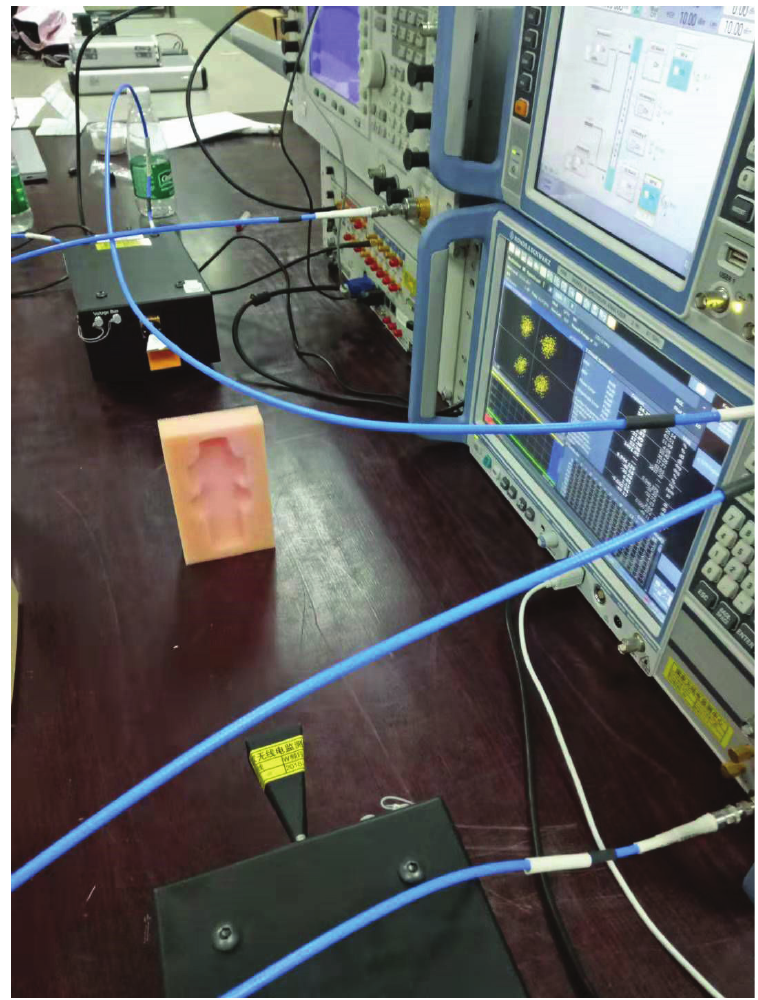
Figure 8. Indoor channel sounding scene